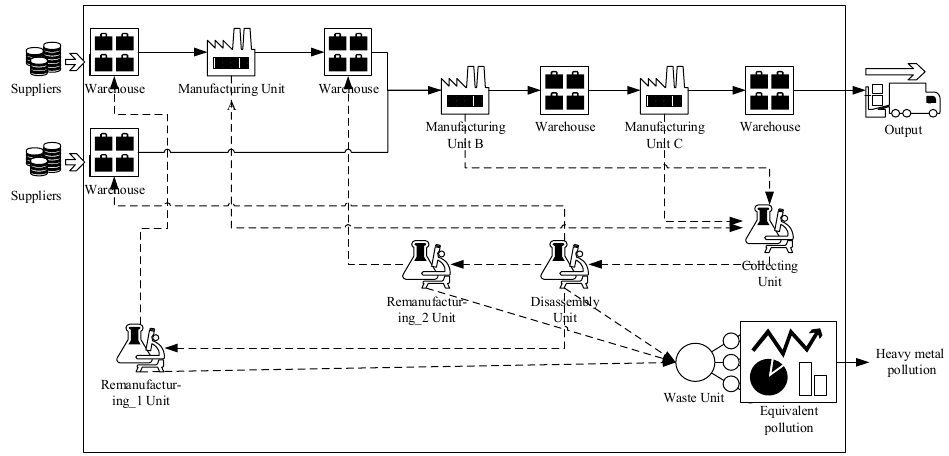
Figure 1. Structural framework for the closed-loop manufacturing-recycling